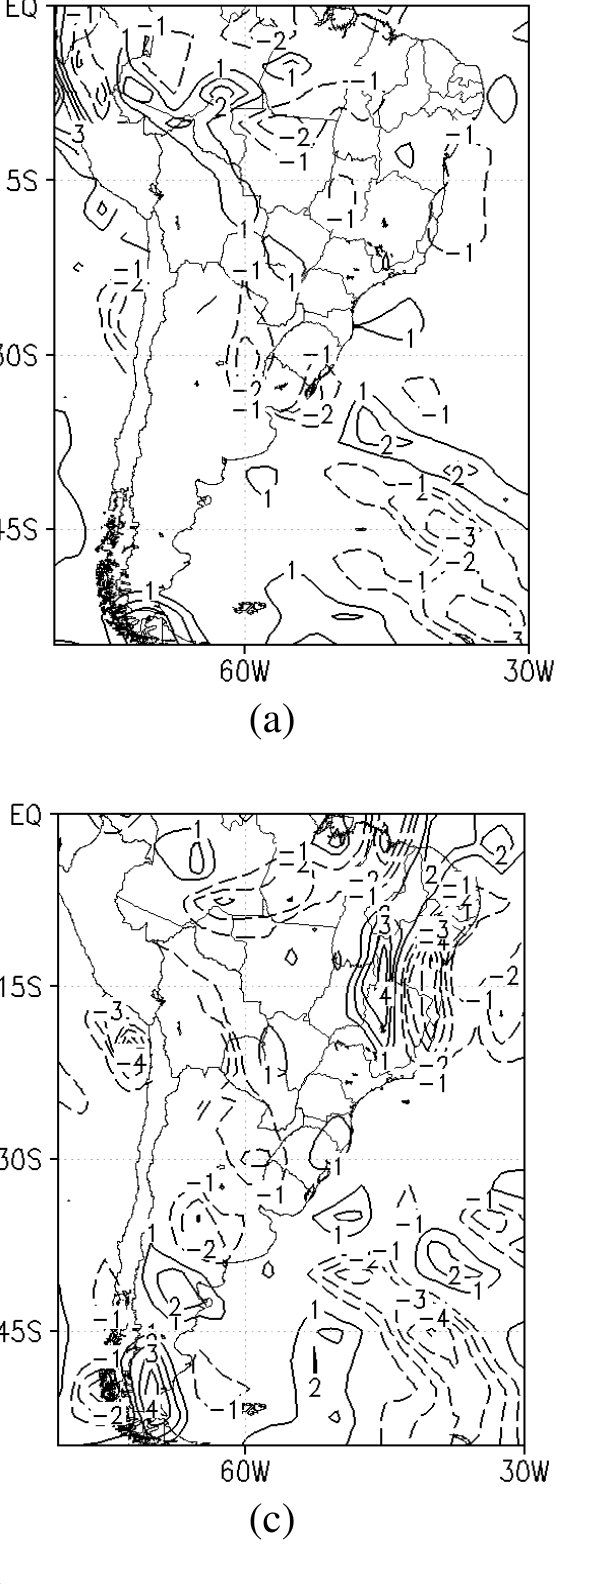
Fig. 17 – Same as in Fig. 16, except for the fields of horizontal advection of humidity. Fig. 17. Same as in Fig. 16, except for the fields of horizontal advection of humidity.